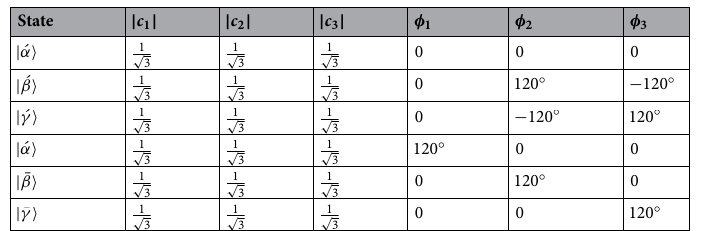
Table 1. The parameter settings for biphoton states from two mutually unbiased bases used in our QKD scheme. The complex amplitudes | c i | are realized through the use of half-wave plates. The φ i are realized by use of phase shifters.